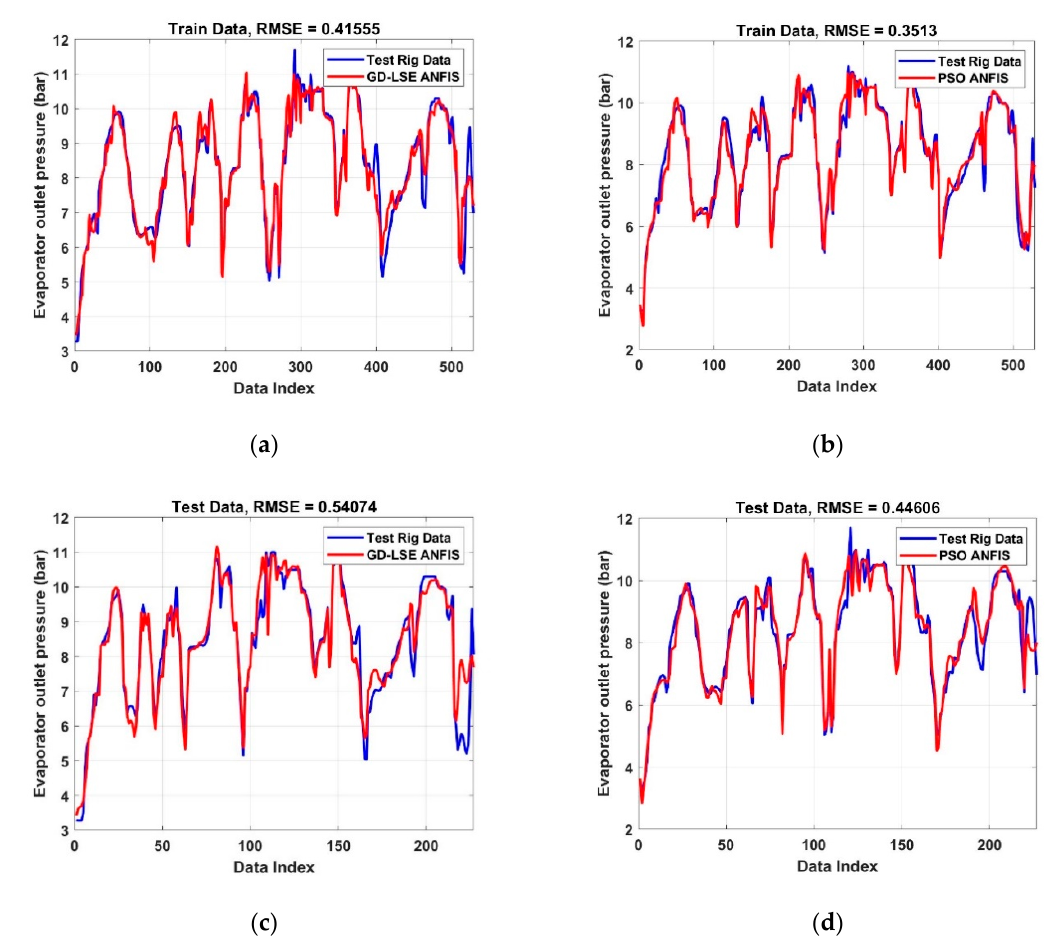
Figure 7. Comparison of GD-LSE ANFIS and PSO ANFIS model predictions of the evaporator outlet pressure, P r,out , using training and test data: ( a ) training data (GD-LSE); ( b ) training data (PSO); ( c ) test data (GD-LSE); and ( d ) test data (PSO).